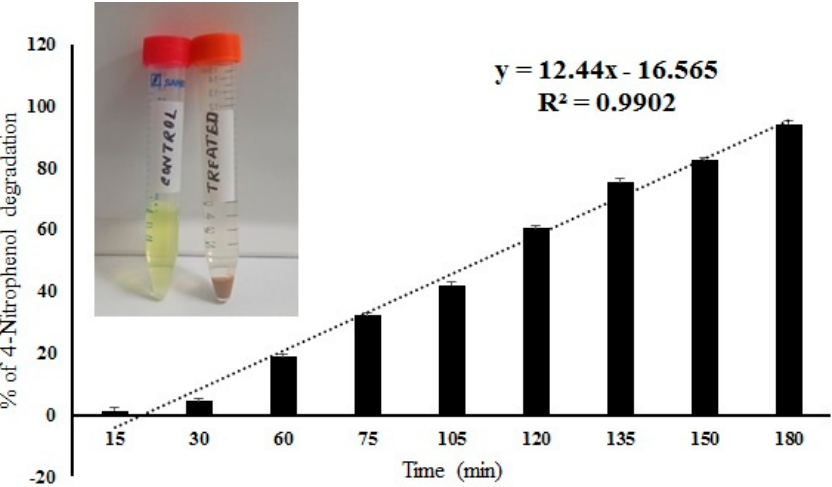
Figure 9. Percentage of 4-nitrophenol degradation by IONPs doped frustules of P. trainorii and experimental solution of 4-nitrophenol before and after treatment with IONPs loaded frustules of P. trainorii.